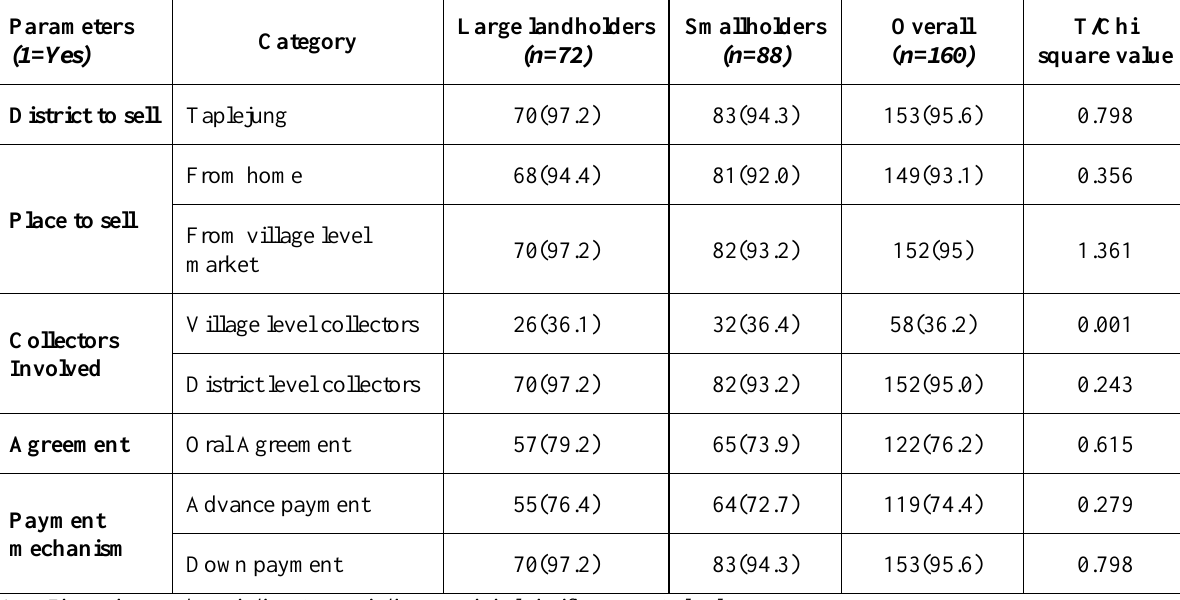
Table 9. Marketing of large cardamom in the study